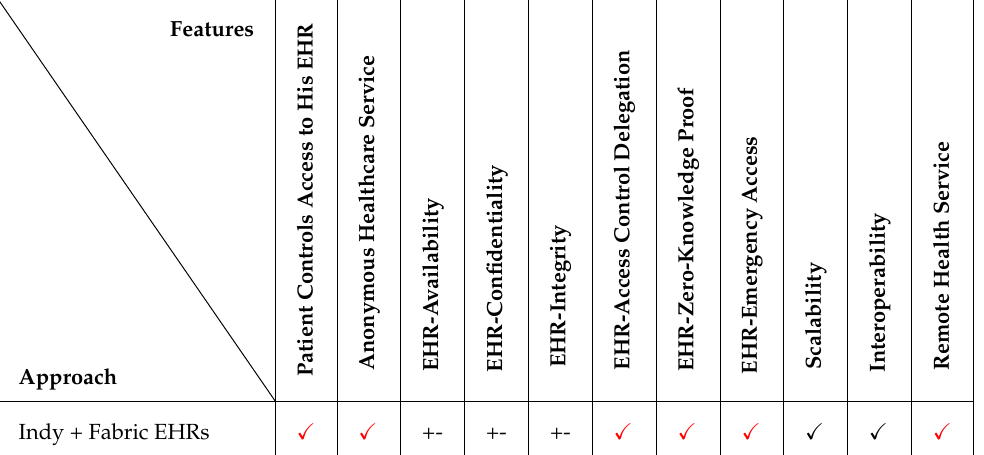
Table 8. EHR protection. During transmission During transmission Wallet (Provider to Patient) (Patient to Consumer) EHR protection public key of Patient public key of Patient public key of Consumer The updated solution has the features given in Table 9. Table 9. Features of the Architecture Based of Hyperledger Indy and